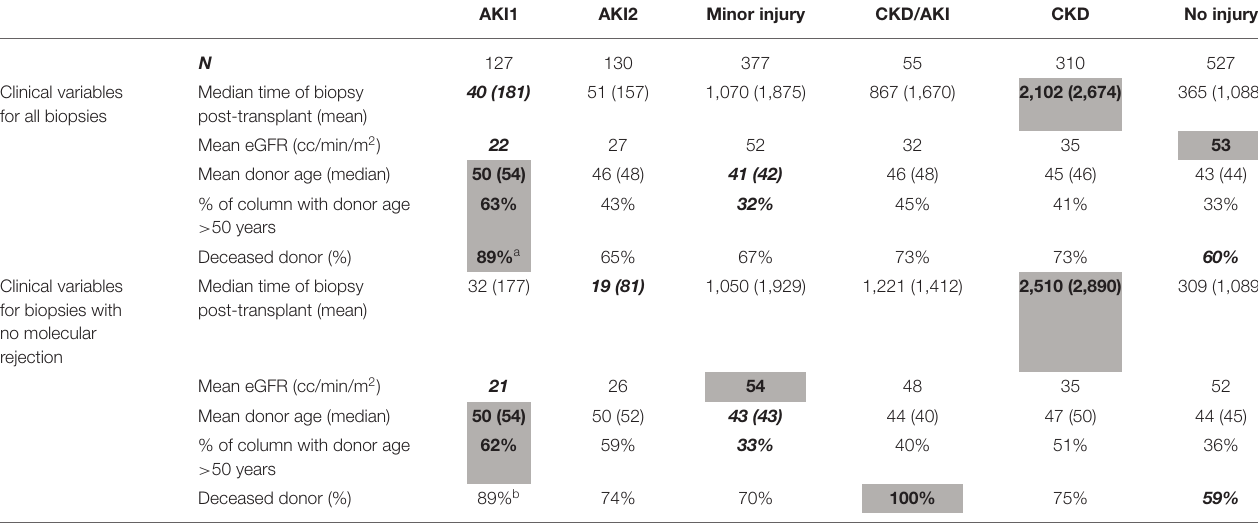
TABLE 1 | Summary of clinical features of the injury archetype groups.